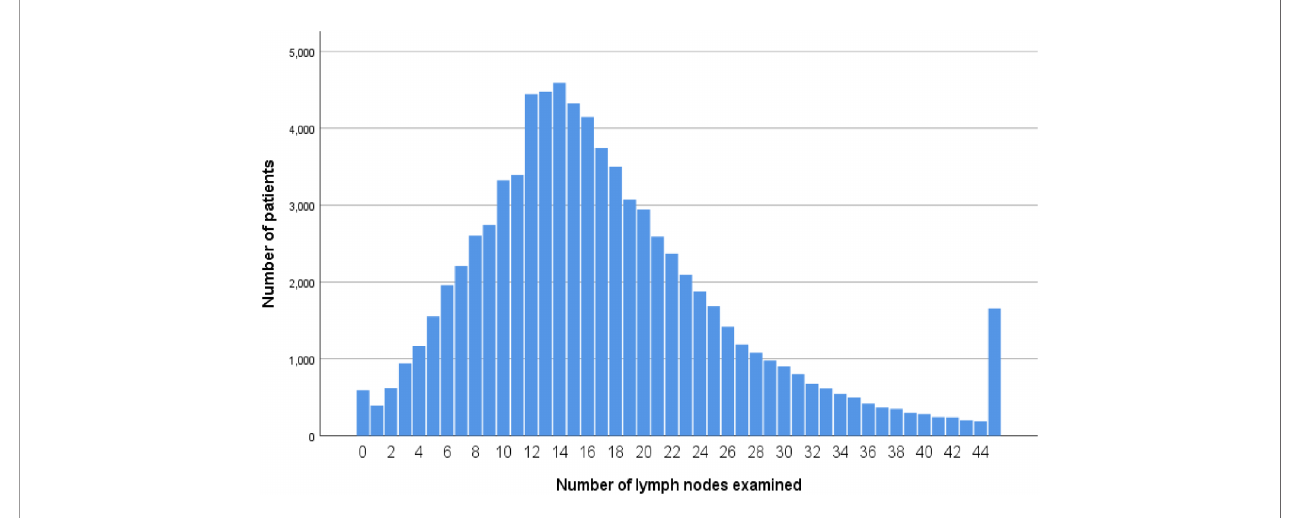
FIGURE 1 | Distribution of numbers of lymph node retrieved.